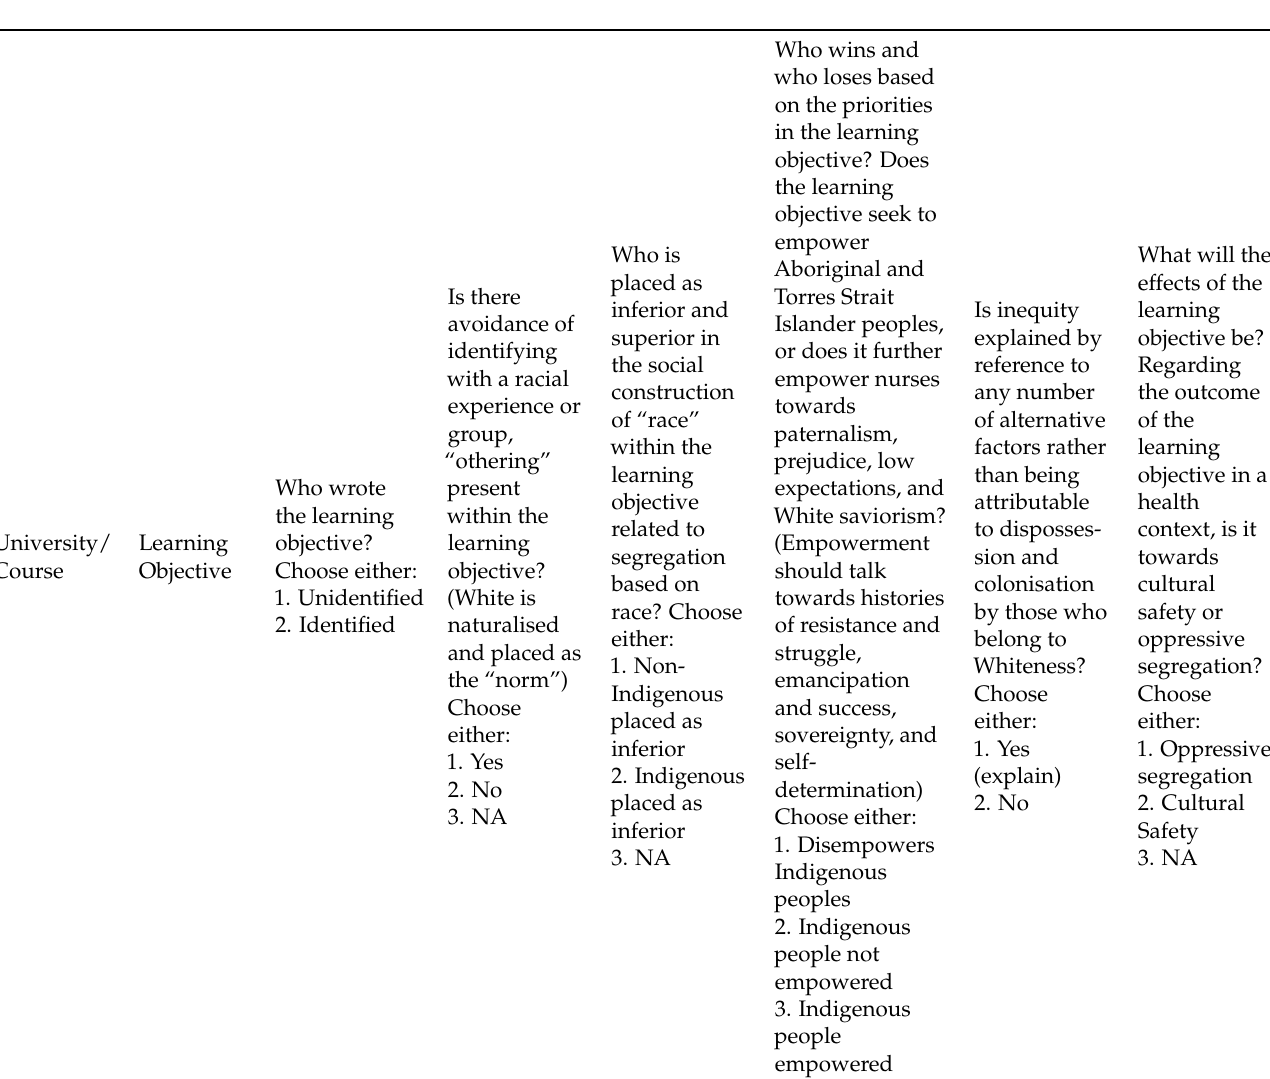
Table A1. Data extraction